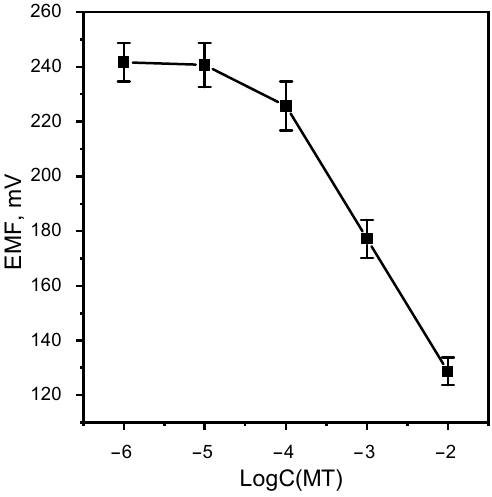
Figure 7. Calibration graphic MT-SE.